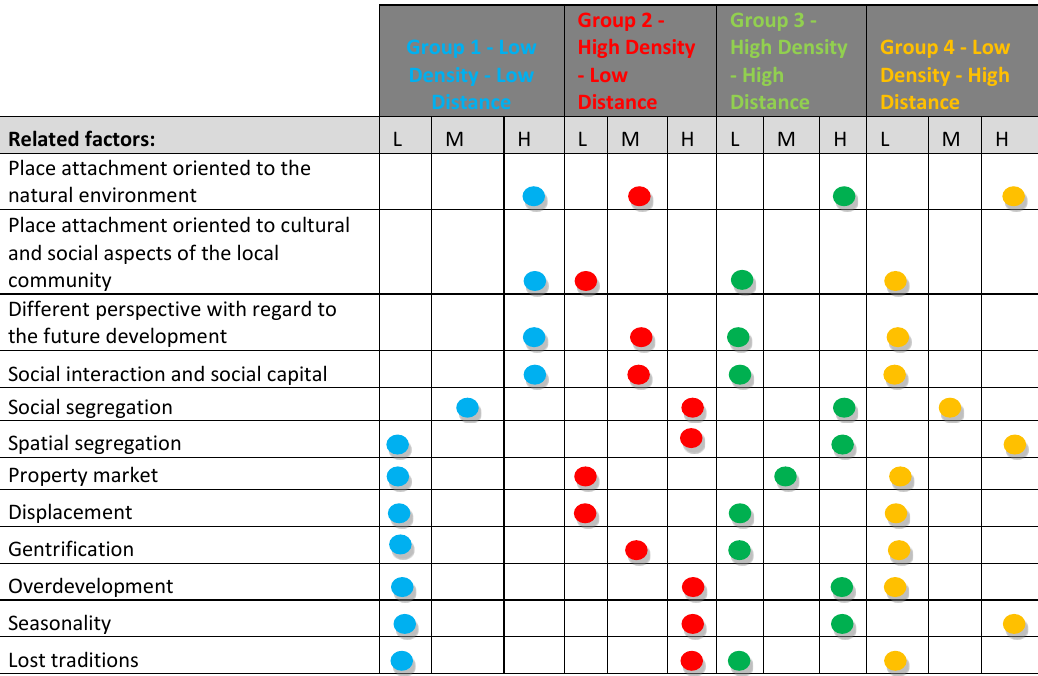
Table 2: The factors and the intensity of the possible effects for each group (based on our own considerations according to the literature and the results of the spatial statistical analysis) Group 1 -